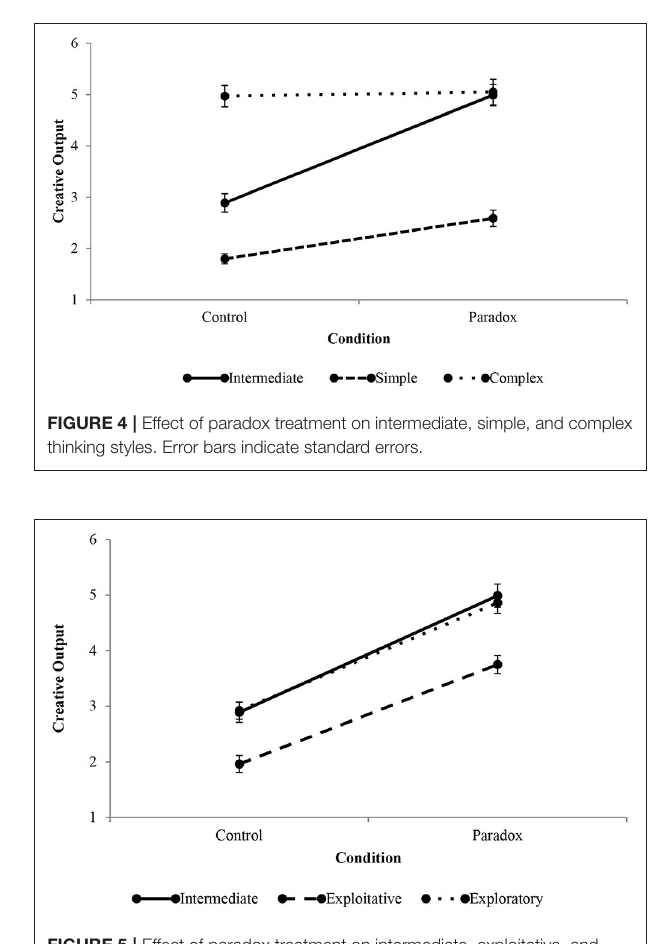
FIGURE 5 | Effect of paradox treatment on intermediate, exploitative, and exploratory thinking styles. Error bars indicate standard